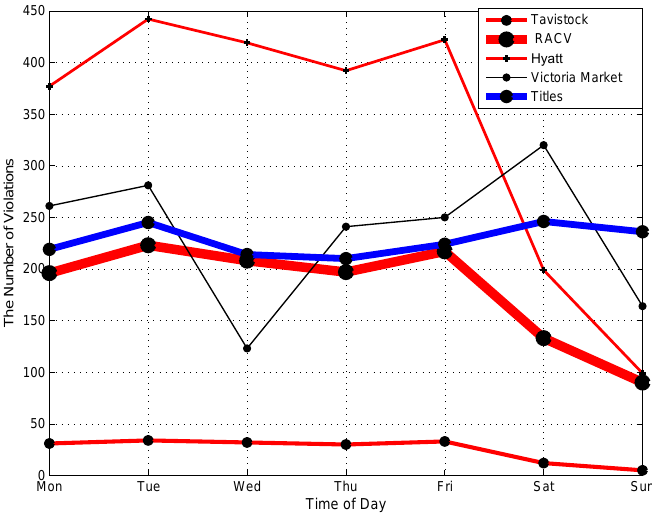
Figure 7. Temporal distribution of parking violations on different days in a week.